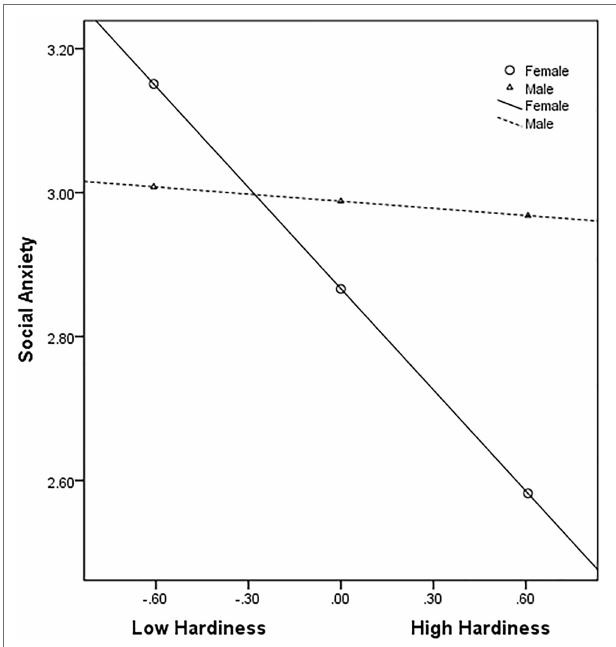
FIGURE 3 | Moderating effect of gender on the relationship between hardiness and social